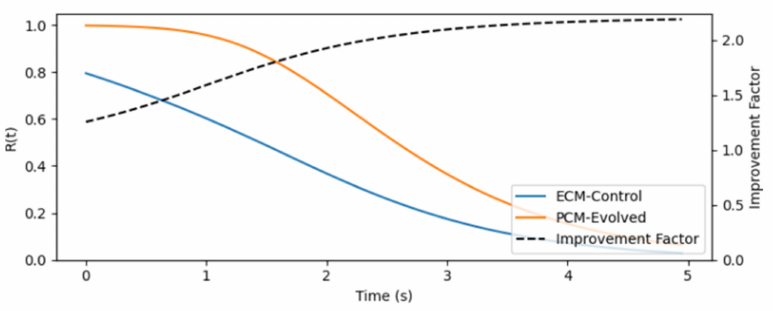
Figure 34. LSSE output for the MTBRF and Reliability Improvement Factor of an experiment with 1000 MASs, with leaf node transfer restricted, with 6 tasks and 20 agents in each